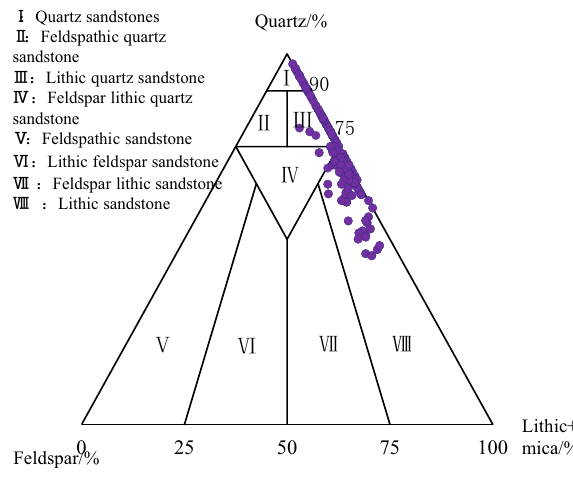
Fig. 3 Petrologic characteristics of